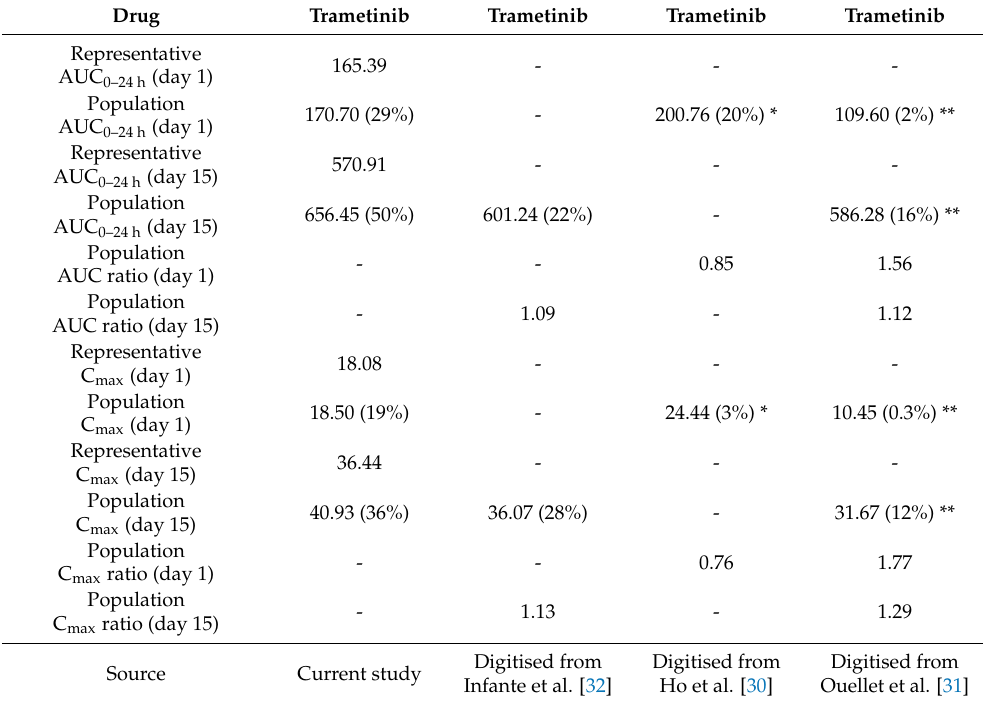
Digitised from Ouellet et al. [31]